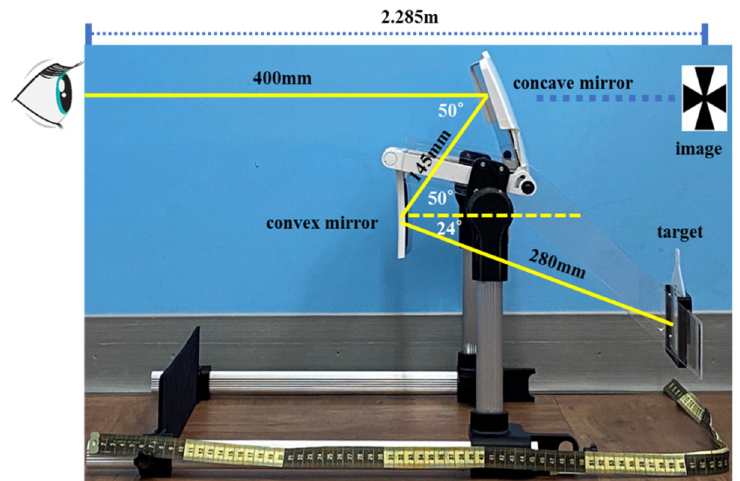
Figure 1. Design of the double-mirror system and simulation of the image position. The image observed by a user is a target of 10 mm × 10 mm, which is at the right- bottom side of the double-mirror system and can be analyzed using the optical software, LightTools, illustrated in Figure 2 [21]. In the simulation, the concave mirror is of 140 mm wide and 70 mm high, with a curvature radius of 706.7 mm in the y-z plane and 745 mm in the x-z plane. The convex mirror is also 140 mm wide and 70 mm high, with a spherical curvature radius of 706.7 mm. When viewing the target through the double-mirror system, both eyes rotate to a vergence angle of 1.62° and can observe an enlarged image at 2285 mm with a size of 0.254 mm wide and 0.195 mm high, as shown in Figure 3a,b for the left and right eyes, respectively. A directly viewed image of the same target at 2285 mm is 0.075 mm wide and is shown in Figure 3c for comparison. The simulations indicate that the magnification of the double system is around 3.386 X along the horizontal direction and 2.6 X along the vertical direction. In fact, these values are obtained by assuming the pupil distance to be 65 mm and can vary significantly for different pupil distances. Besides the magnification difference between the horizontal and the vertical axes, directions needs to be improved for further applications. Figure 2. Optical layout of the double-mirror system built in the optical software, LightTools.